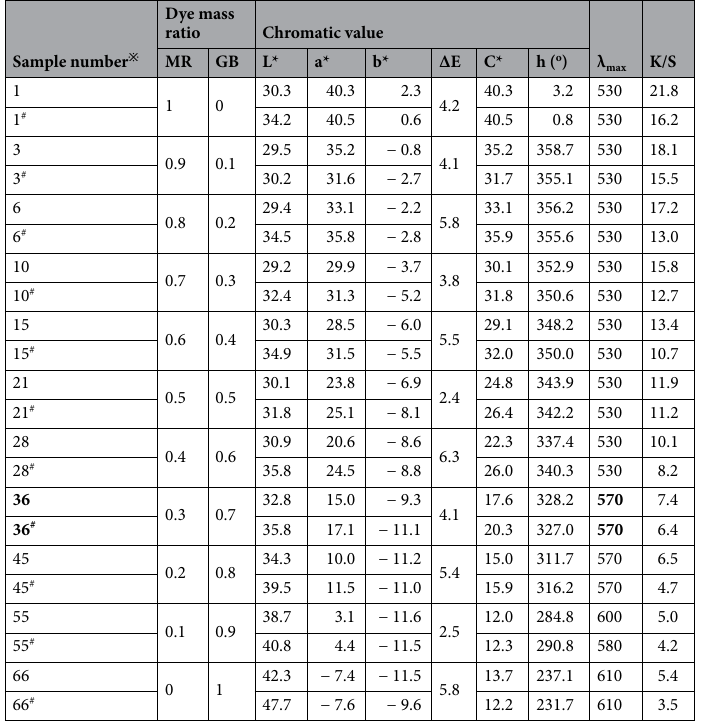
Table 2. Chromatic values of wool yarns dyed with binary mixtures of MR and GB. Significant values are in [bold].